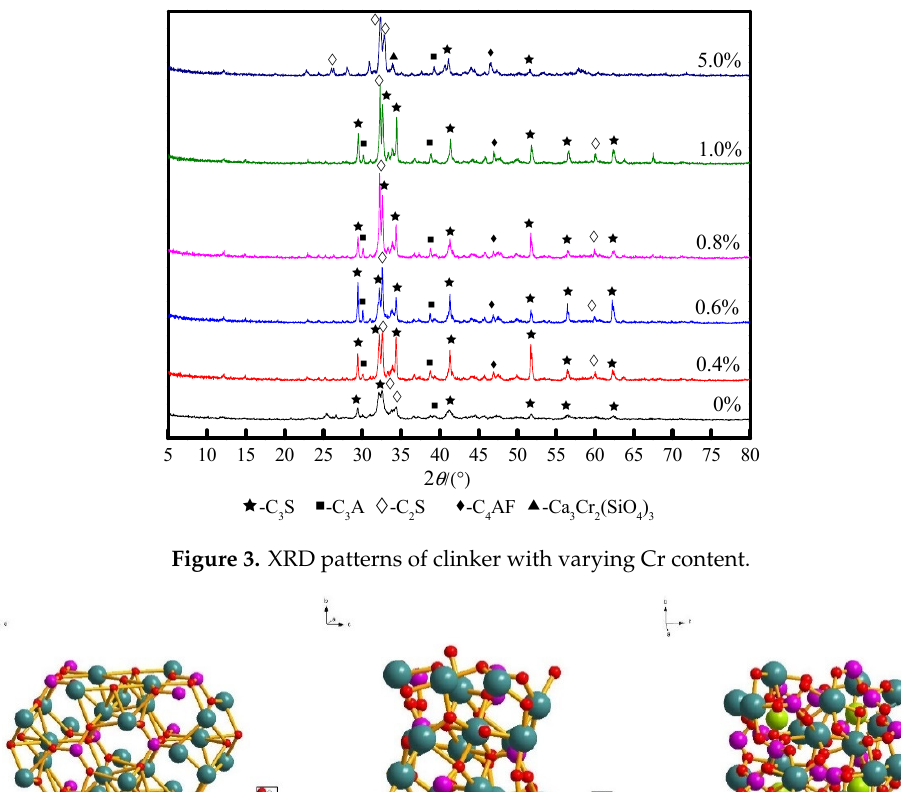
Figure 4. Crystal structure of silicate minerals. Table 4. Ionic radius, coordination number, and electronegativity of